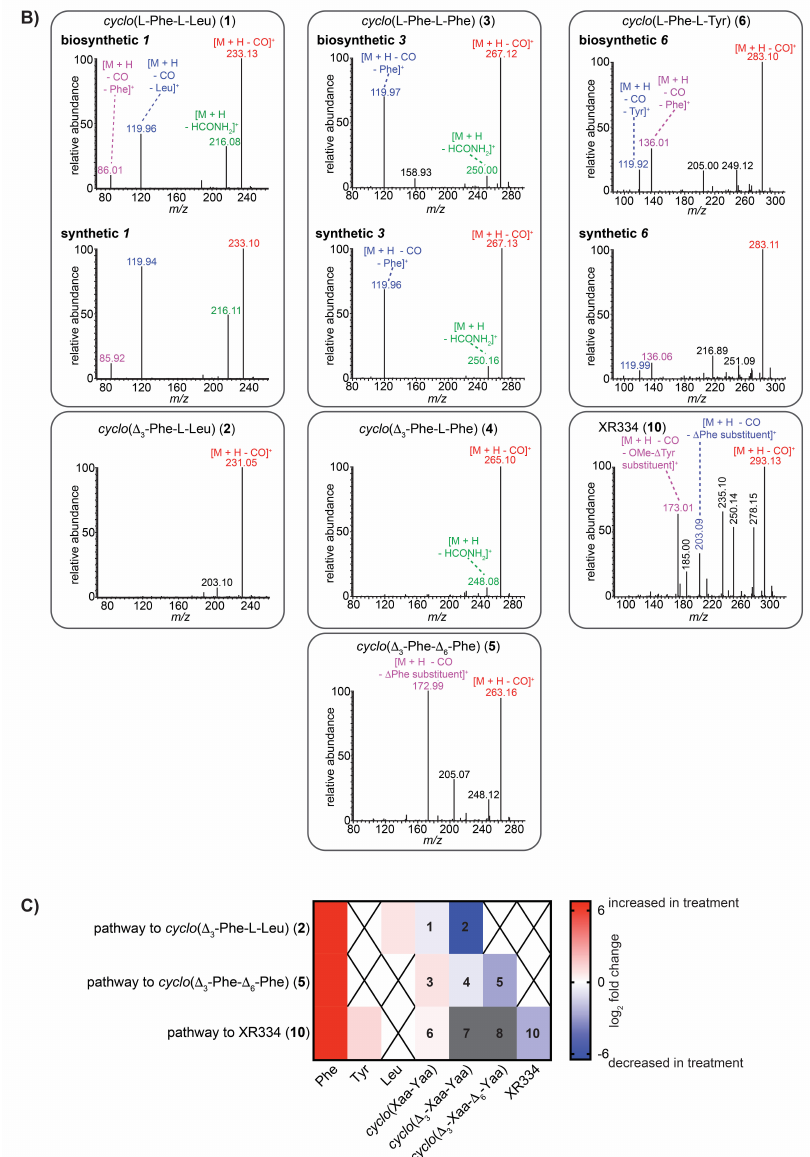
Figure 4. Application of IROA metabolomics for evaluating impacts of small molecules on targeted natural product biosynthetic pathways. Impacts of bipyridyl on N. dassonvillei production of DKPs 1–10 were evaluated. ( A ) The previously reported biosynthetic pathway for 1–10 includes aminoacyl tRNA synthetase (AARS)-catalyzed ligation of amino acids with tRNAs, followed by cyclodipeptide synthase (CDPS)-catalyzed formation of DKPs 1, 3, and 6 from di ff erent combinations of aminoacyl-tRNAs. Tailoring of these DKP intermediates by a cyclic dipeptide oxidase (CDO) and / or methyltransferase (MT) leads to final products 2, 5, and 10 [38]. ( B ) LC / MS 2 supported identification of each DKP from N. dassonvillei extracts. Comparison of MS 2 fragments for 1, 3, and 6 from N. dassonvillei with synthetic standards supported their identification, while dehydrogenated and / or methylated derivatives were confirmed by correspondence between observed fragments shown in color with literature values [38,42]. ( C ) Heatmap of mean ( n = 4) log 2 fold changes in abundance of DKP pathway metabolites in response to bipyridyl. From left-to-right, the heatmap is arranged in the order of precursors leading to final DKPs 2, 5, and 10. Map fields marked with “X” indicate metabolites not required for production of the final DKP indicated in that row, fields in gray indicate previously reported pathway intermediates that were not detected in our experiments, and numbers superimposed within the heatmap correspond to compound numbers from ( A ). Xaa and Yaa indicate Phe, Leu, or Tyr residues of